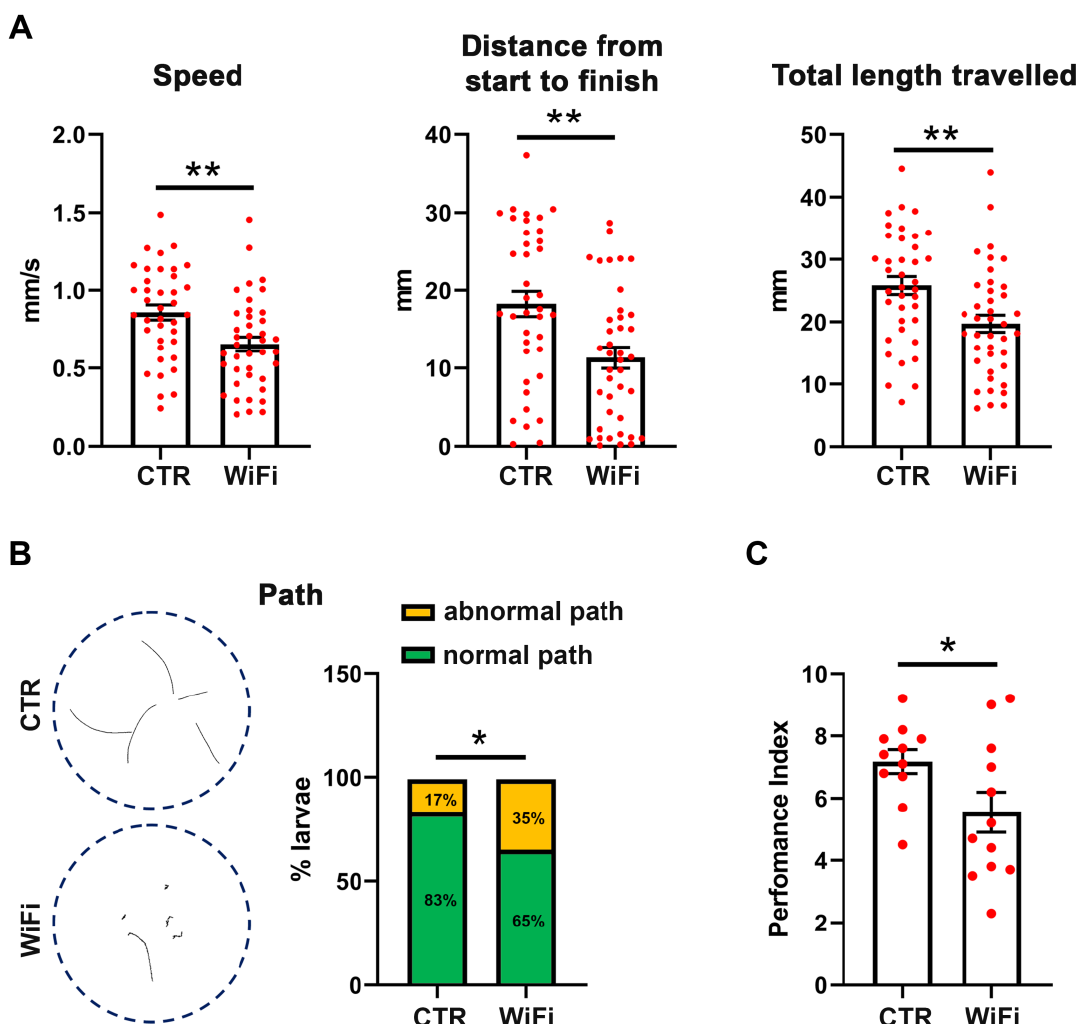
Figure 7. ( A ) Larval crawling patterns of control and WiFi-exposed third instar larvae. Quantitation of the speed was in millimeters per second, distance from start to finish, and total length travelled (speed × time) were in millimeters. Red dots indicate individual data points from eight independent biological replicates. Data were analyzed using the Unpaired t test (** p ≤ 0.01). ( B ) Schematic illustration and quantification of larval trailing paths following WiFi exposure. Statistical significance was determined by Fisher’s exact test (* p ≤ 0.05). ( C ) Climbing assay on 10-days old unexposed control and WiFi exposed flies. Red dots indicate individual data points from two independent biological replicates. Statistical significance was determined using the Unpaired t test (* p ≤ 0.05).